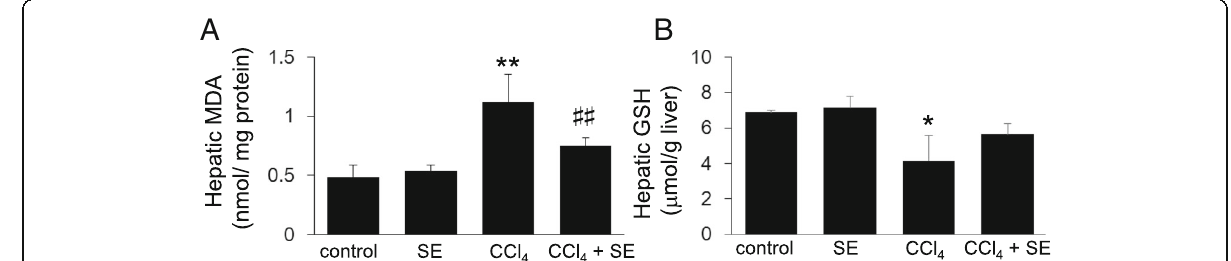
Fig. 4 Effect of SE on the levels of hepatic MDA and GSH levels. Animals treated as described in Fig. 2 were euthanized 72 h post intraperitoneal injection, and the livers were harvested at necropsy. Liver specimens were assessed for MDA levels ( a ) and GSH levels ( b ). Data are plotted as mean ± SD for groups of 6 mice each. * indicates p<0.05 versus control group , ** indicates p<0.01 versus control group, and ## indicates p<0.01 versus CCl 4